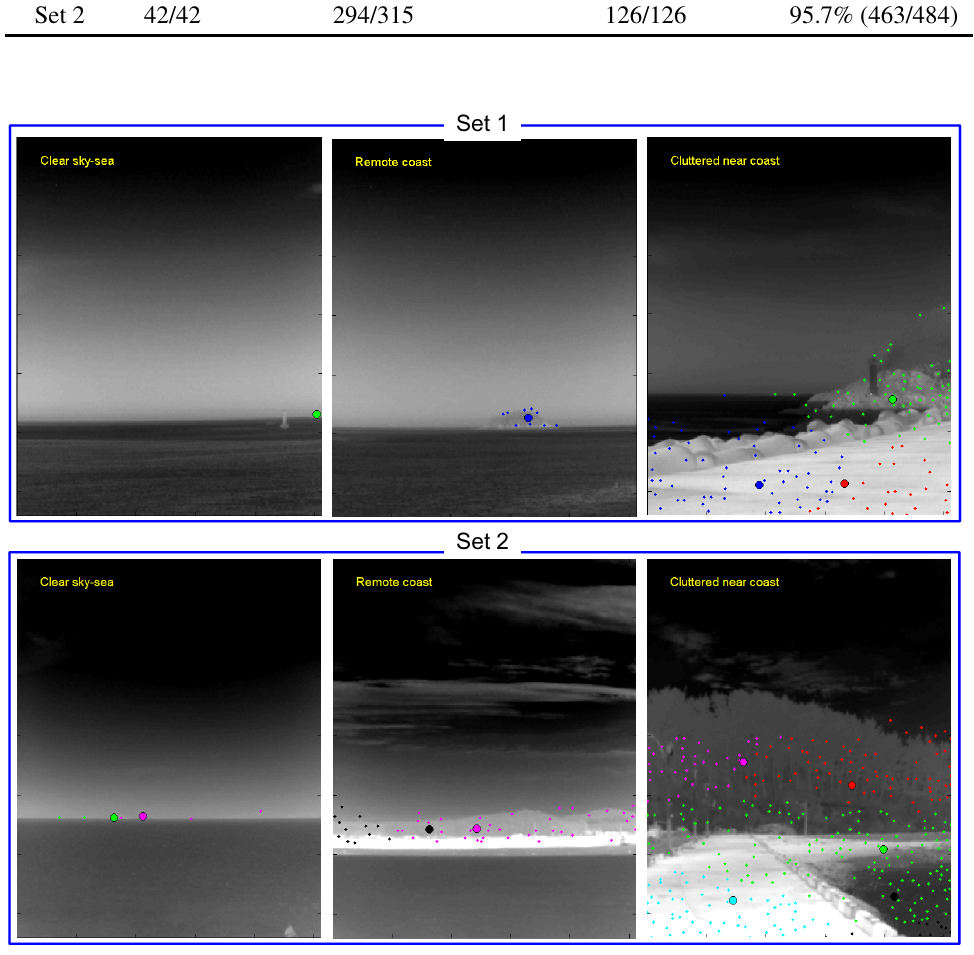
Figure 21. Examples of successful infrared scene type